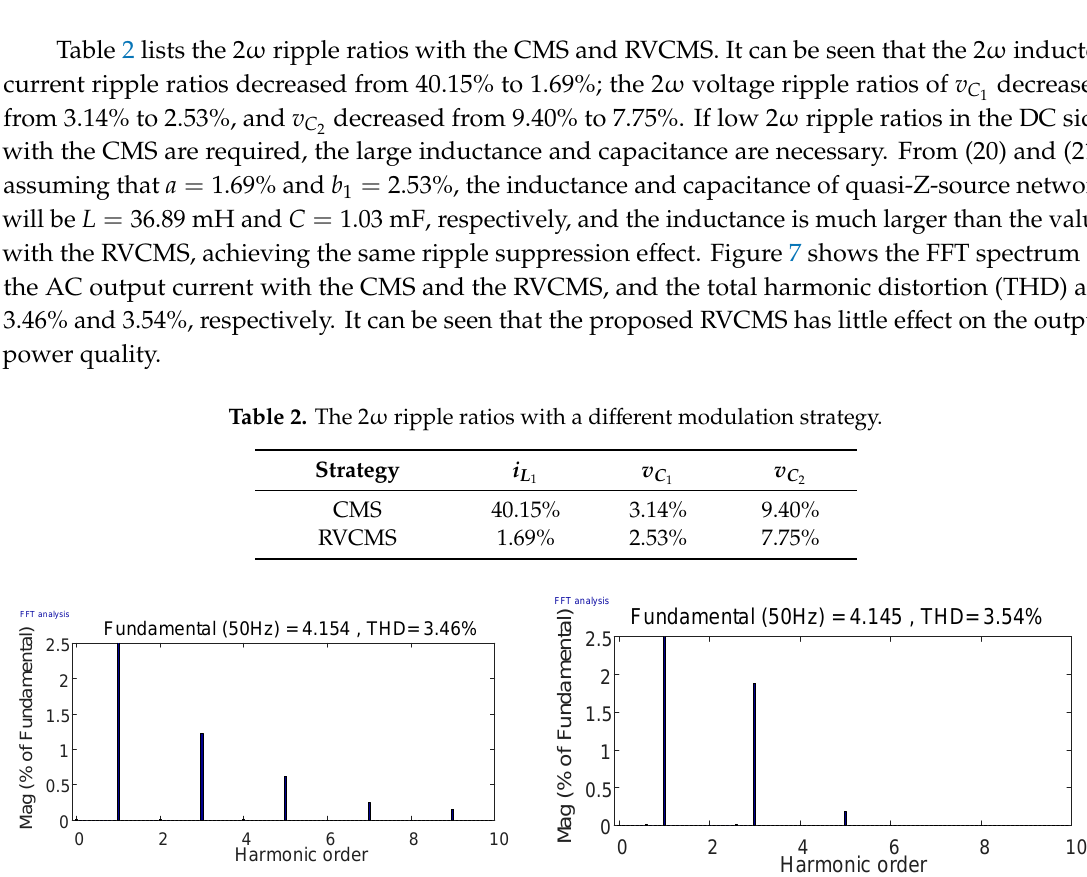
Figure 6. Simulation results of d ( a ),